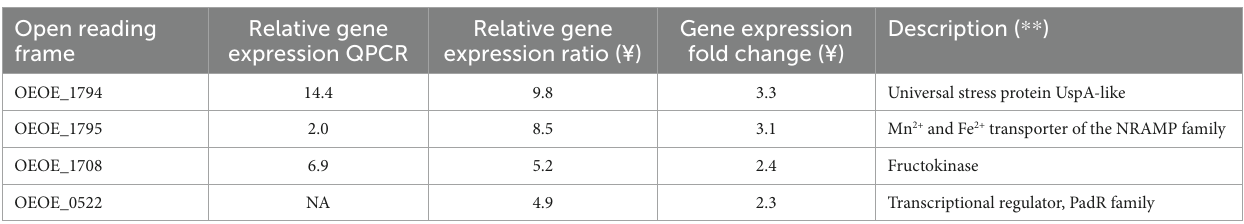
TABLE 3 Gene expression rate of E1 compared to PSU-1 ( *